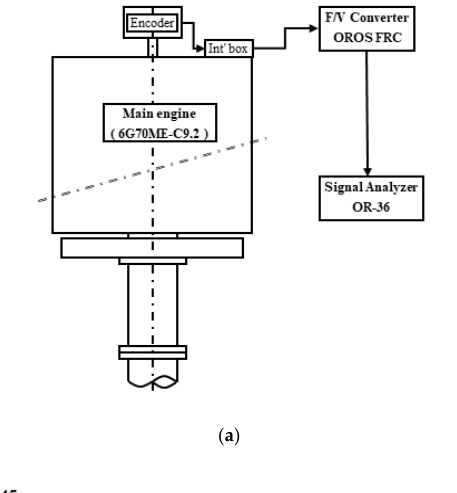
Figure 2. ( a ) De-rating ratio of ships with an ultra-long-stroke engine. ( b ) Comparison of sixth-order vibratory torque of an ultra-long-stroke engine with de-rating technology according to varied mean effective indicated pressure.